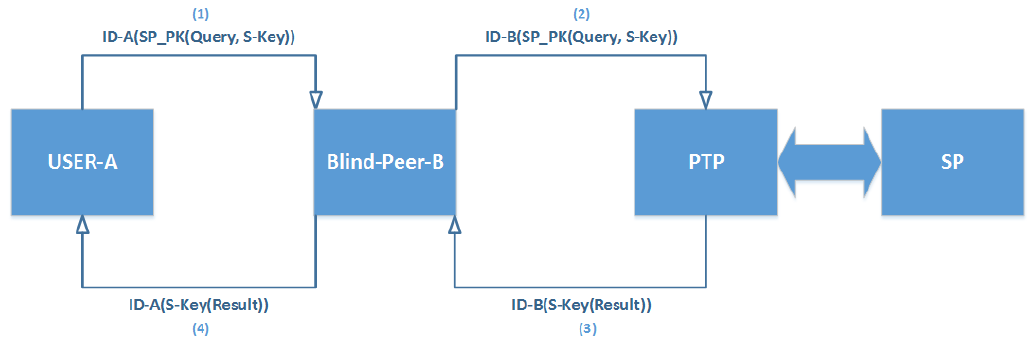
Figure 12. Integrated Blind Parties